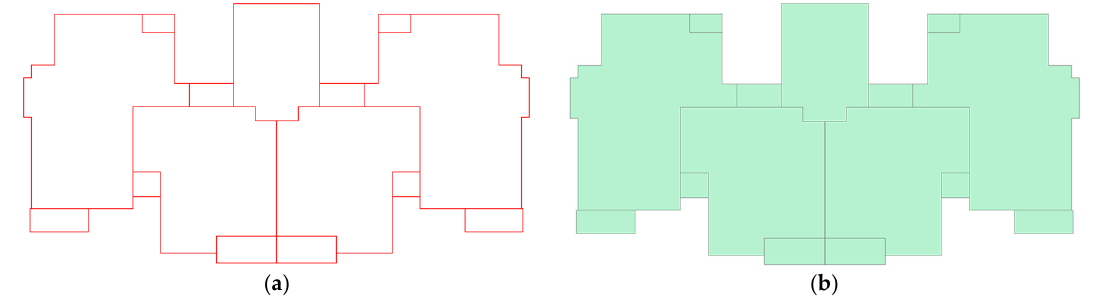
Figure 15. ( a ) Footprint faces represented by lines or polylines in the original data; and ( b ) polygons that were converted from lines or polylines by the conversion tool.